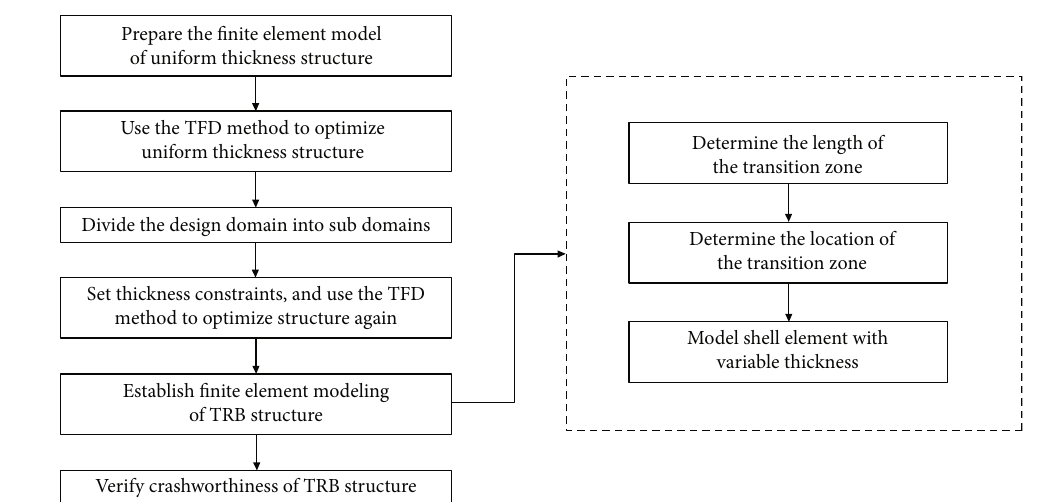
Figure 3: Optimization technology roadmap based on TRBs.